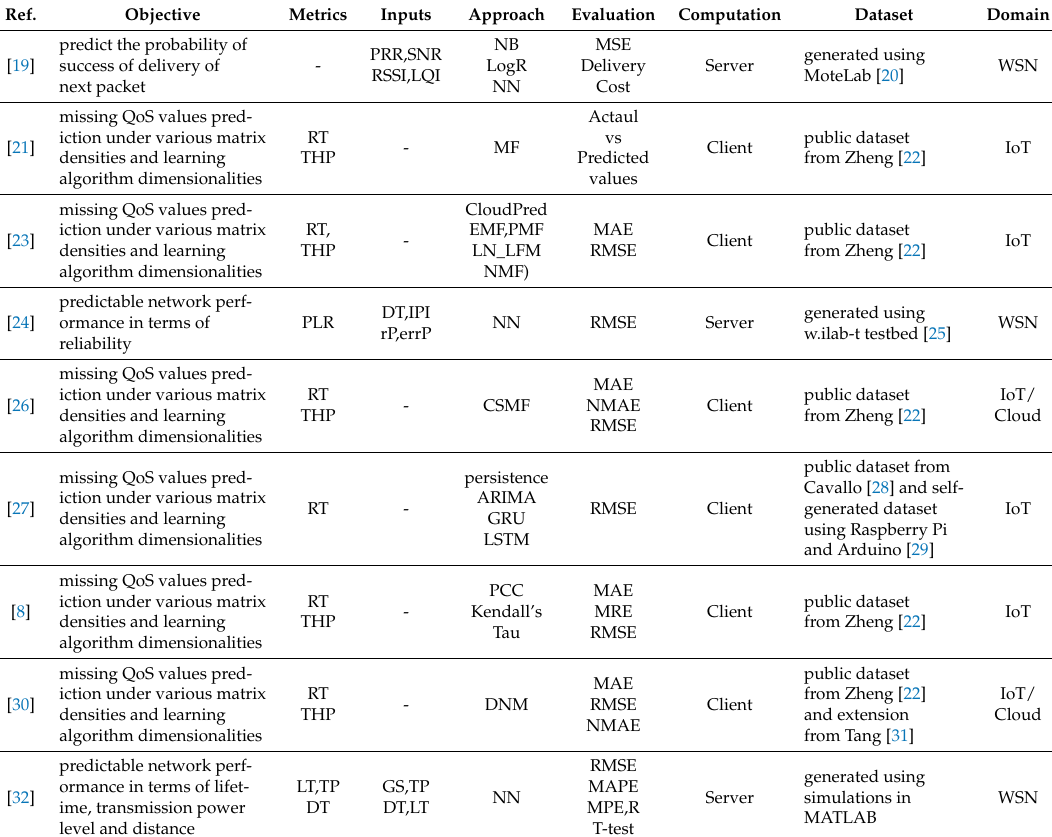
Table 1. Literature